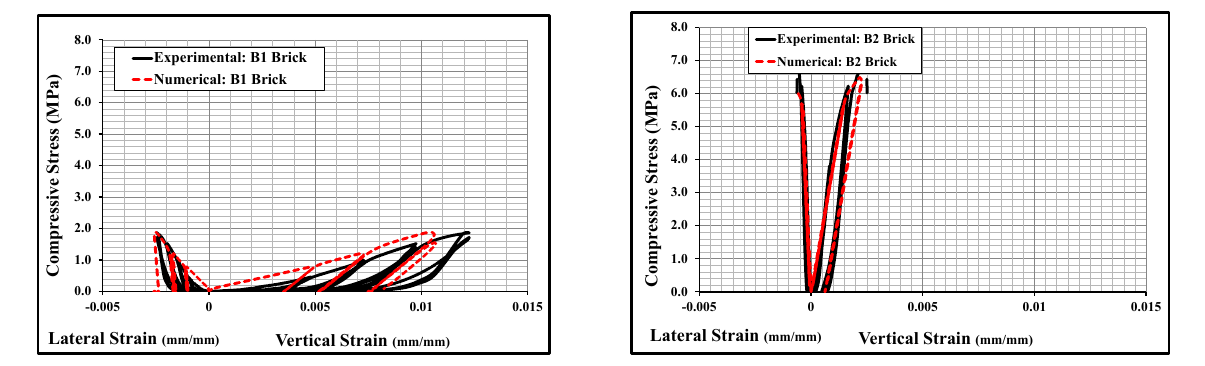
Figure 9. Stress-strain responses of the wallettes under cyclic compression test; ( a ) B1 and ( b ) B2 wallettes.